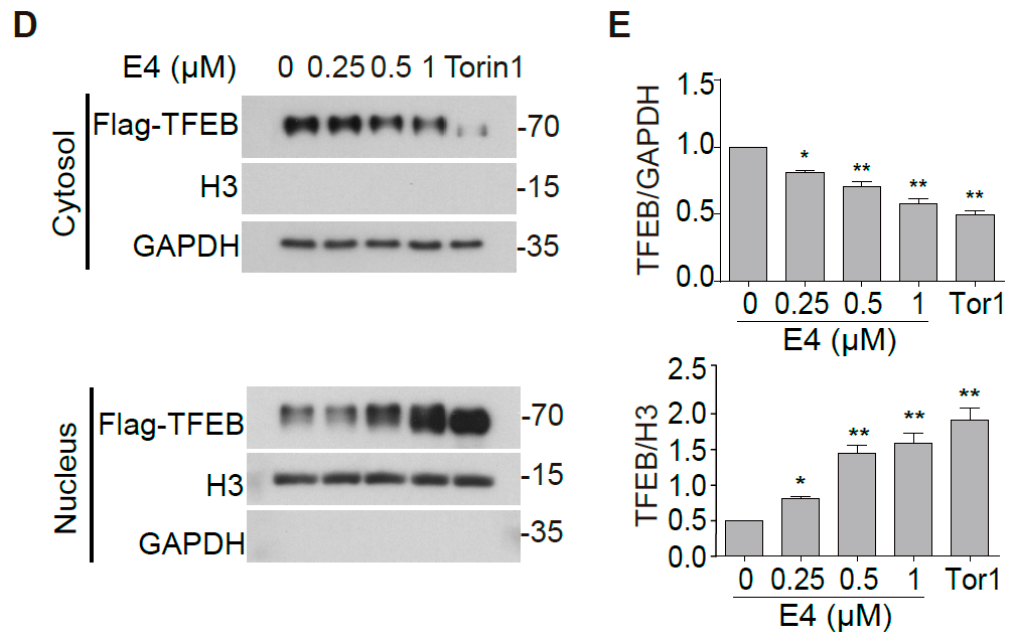
Figure 1. Compound E4 promoted the nuclear translocation of endogenous and exogenous transcription factor EB (TFEB) in vitro. ( A ) Chemical structure of E4. ( B ) E4 significantly promoted the nuclear intensity of endogenous TFEB in N2a cells compared to control (0.1% DMSO). After being treated with E4 (1 µ M) for 24 h, N2a cells were fixed and stained with the anti-TFEB antibody (red) and DAPI (blue). Representative images are shown. Scale bar: 15 µ m. ( C ) E4 significantly promoted the nuclear intensity of TFEB in CF-7 cells compared to control (0.1% DMSO). After being treated with E4 (1 µ M) and positive control Torin1 (250 nM) for 24 h, HeLa cells stably expressing 3XFlag-TFEB (CF-7) were fixed and stained with the anti-Flag antibody (green) and DAPI (blue). Representative images are shown. Scale bar: 15 µ m. Quantification of the number of cells with nuclear TFEB localization. Data are presented as mean ± SEM of three replicates in a representative experiment. At least 100 cells were analyzed in each treatment group. ( D ) The expression of Flag-TFEB in the cytosol and the nucleus in CF-7 cells were detected by Western blotting after being treated with indicated compounds for 6 h. ( E ) Relative intensity of TFEB is normalized to that of GAPDH and H3. Data are presented as mean ± SEM of three replicates in a representative experiment. * p < 0.05, ** p < 0.01, *** p < 0.001.